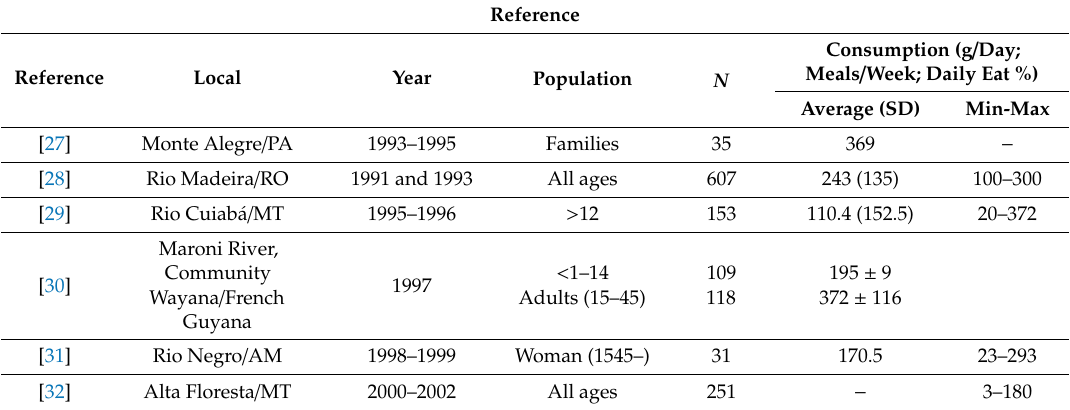
Table 2. Summary of articles that quantified fish consumption in communities in the Brazilian